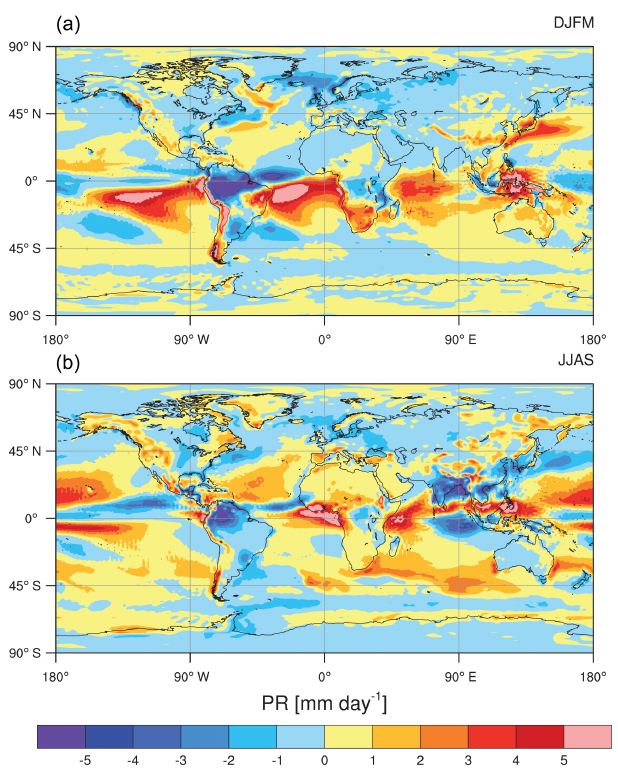
Figure 5. Biases in simulated photosynthetically available radi- ation (PAR) compared to the Surface Radiation Budget (SRB) satellite-derived observations (Pinker and Laszlo, 1992) averaged over 1986–2005. Winter (a) and summer (b) periods are computed from DJFM and JJAS